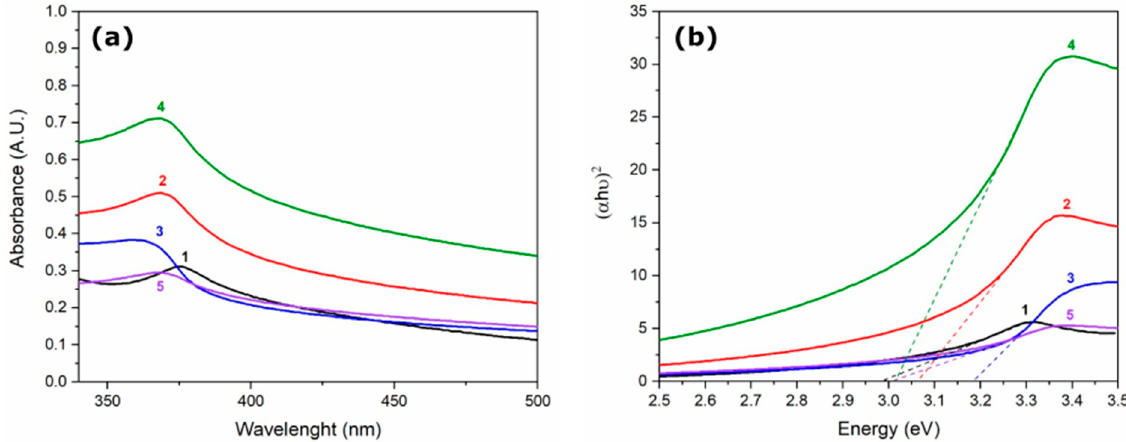
Figure 1. ( a ) Absorption spectra and ( b ) Tauc’s plots for ZnO nanoparticles synthesized with (1 ⎯ ) no extract, (2 ⎯ ) Azadirachta indica , (3 ⎯ ) Chrysanthemum morifolium , (4 ⎯ ) Tagetes erecta , and (5 ⎯ ) Lentinula edodes .